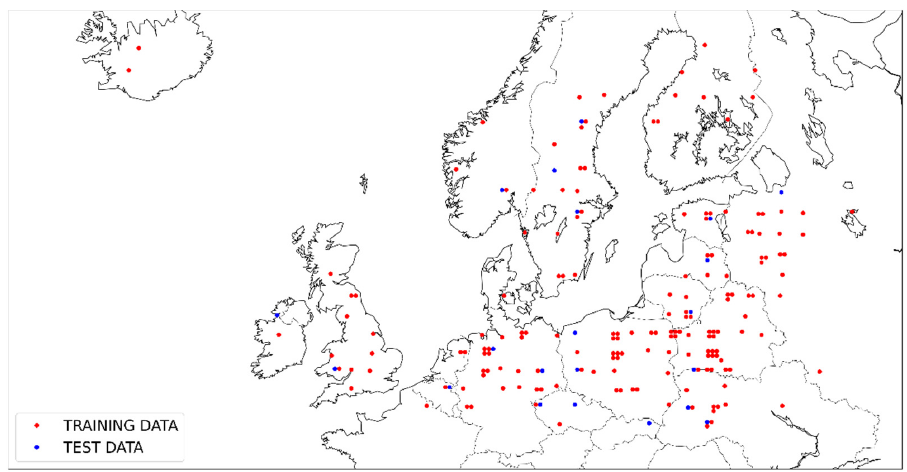
Figure 3. Distribution of the training and test data. Red dots indicate Sentinel-2 images reserved for training and validation dataset, and blue dots indicate images used for the test dataset only. If the dots are exactly next to each other, it means the corresponding Sentinel-2 products are from the same